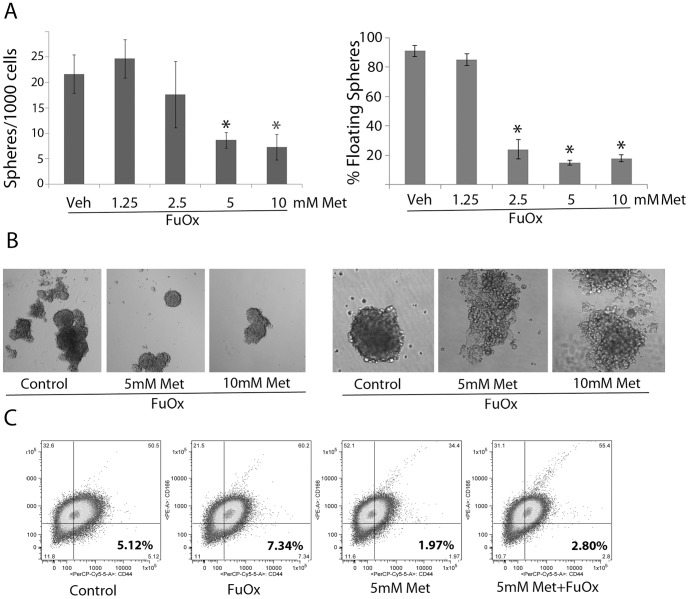
Decreased stem cell characteristics in metformin/FuOx treated CR HT-29 cells.A&B: Formation of primary colonospheres in the presence of metformin and FuOx (left panel). Induction of differentiation and attachment of colonospheres in the presence of metformin/FuOx (right panel). A: graphic representation of the numbers B: photomicrographs of representative spheres. C: Flow cytometric analysis of CD44 and CD166 positive cells after metformin/FuOx treatment.